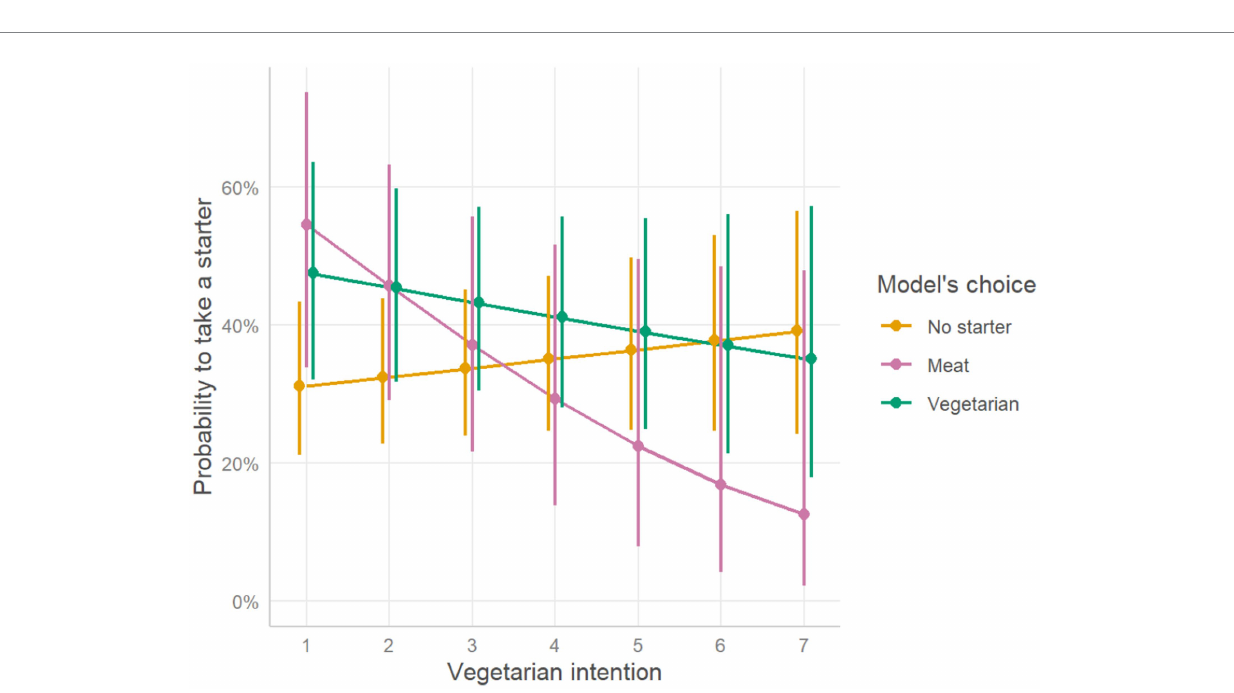
FIGURE 3 Probability to take a starter, as function of vegetarian intention scores. The plot represents estimated effects of intentions on the probability to take a starter for different model’s choices. Oblique lines represent the estimated marginal mean probability of taking a starter, as opposed to not taking a starter, while the error bars represent 95% confidence intervals based on estimated standard errors (+/ − 1.96